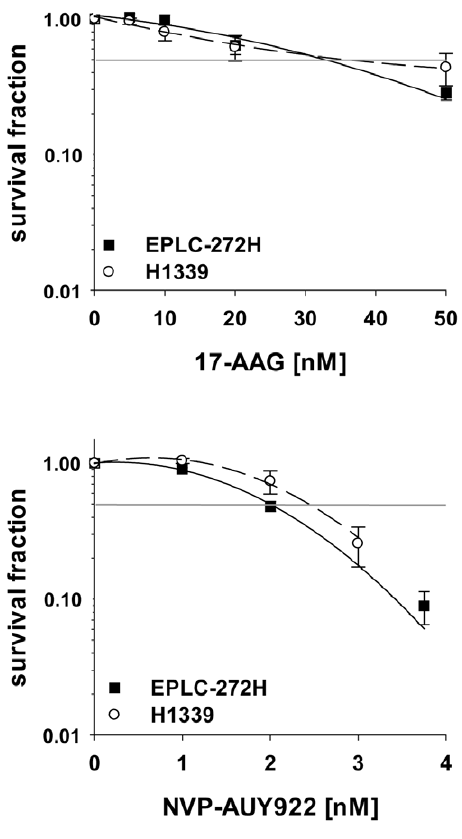
Figure 4. EPLC-272H and H1339 lung cancer cell lines show similar drug-sensitivity. EPLC-272H and H1339 cells were exposed to vehicle control (0 nM), 17-AAG (5–50 nM) or NVP-AUY922 (1–3.75 nM). Drugs were present until fixation of colonies. The survival fraction was calculated relative to the untreated control. Horizontal lines indicate 50% survival fraction. Mean values 6 SEM of at least 4 independent experiments are shown.